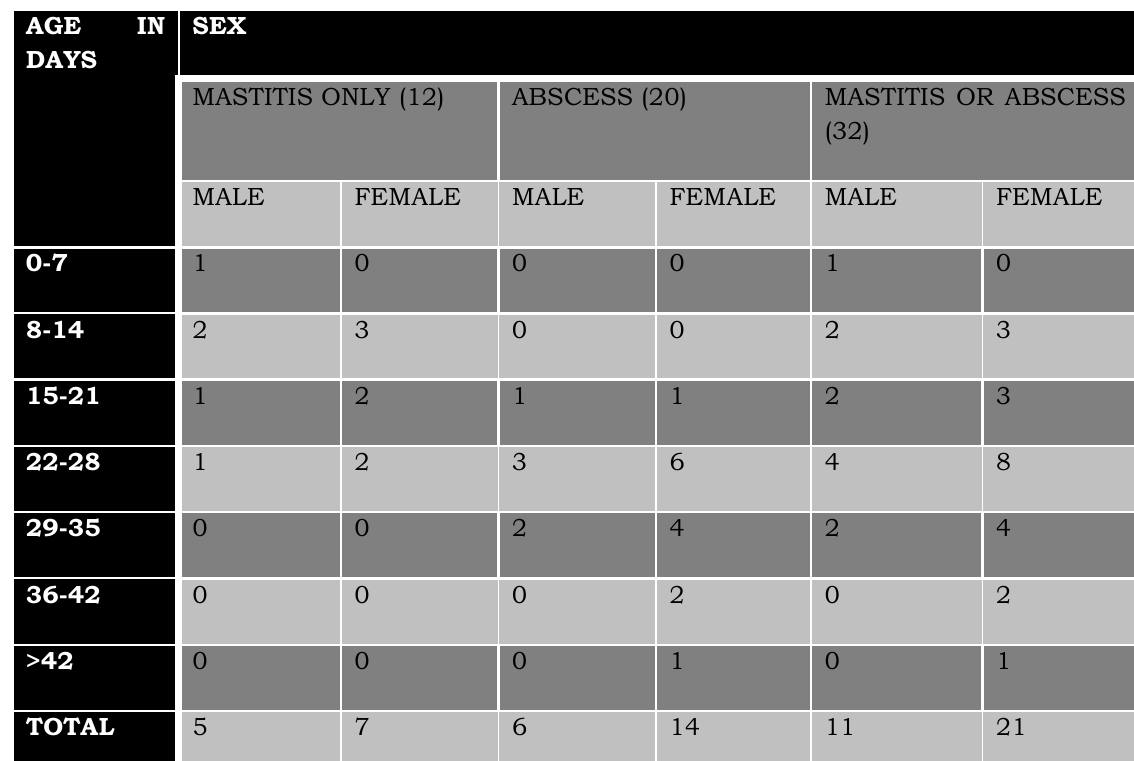
Table.1: Showing the age and sex distribution of the